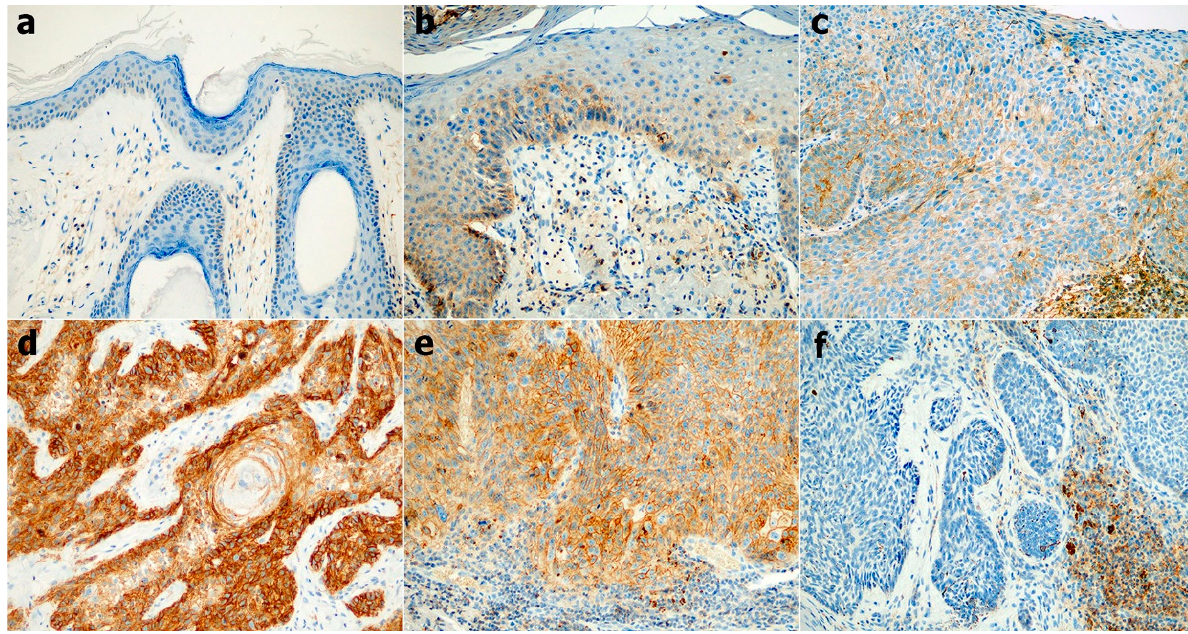
Figure 2. Comparison of CD47 expression in normal skin (NS), actinic keratosis (AK), squamous cell carcinoma in situ (SCCIS), squamous cell carcinoma (SCC), keratoacanthoma (KA), and basal cell carcinoma (BCC). ( p < 0.001, Kruskal–Wallis test). Circles represent mild outliers.